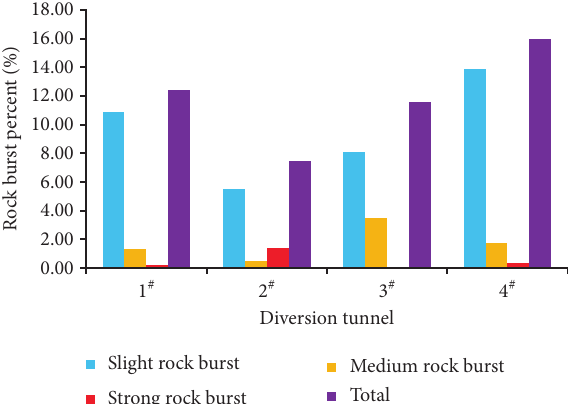
Figure 11: Proportion of different categories of rock burst occurred sections during the excavation of 1 # ∼ 4 # diversion tunnels between the sections of k12+000 ∼ k16